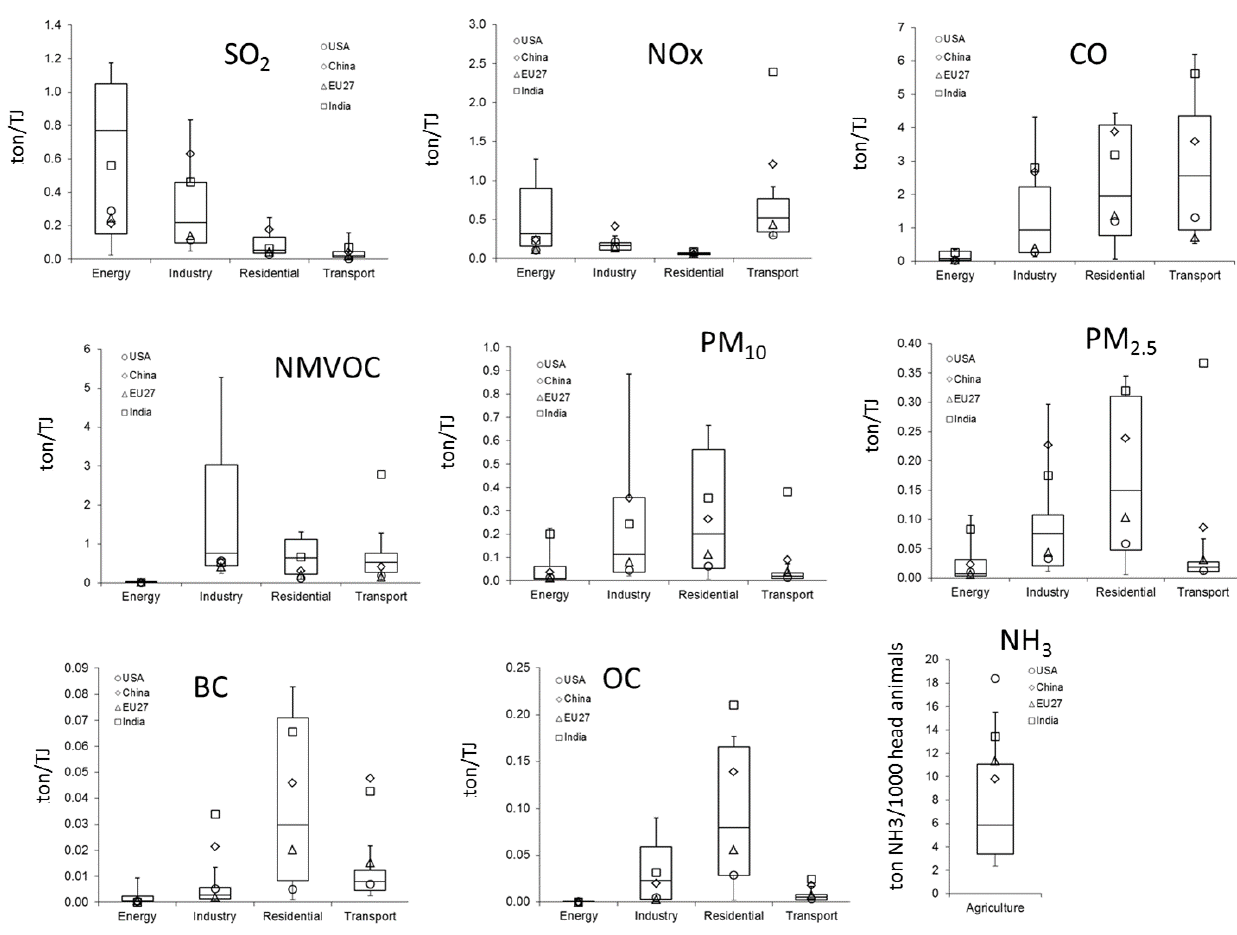
Figure 4. Sector specific implied emissions factors (ton(TJ) − 1 ) for the year 2010. Percentiles are reported in the box plots (10, 25, 50, 75, and 90 ◦ ) together with implied emission factors for specific regions (EU27, USA, China and India). Note – For the percentiles the following countries are left out. For CO – for the industry sector: Togo, Eritrea, Congo, Côte d’Ivoire, Kenya, Benin; for the residential sector: Maldives; for the transport sector: North Korea, Afghanistan, Laos, Tajikistan, Mongolia. For SO 2 – for the industry sector: Namibia, Laos, Jamaica. For NO x – for the residential sector: Maldives; for the TRANSPORT sector: Afghanistan, Laos, North Korea, Tajikistan. For NMVOC – for the energy sector: Bhutan; for the industry sector: Togo, Eritrea, Côte d’Ivoire, Congo, Cameroon, Kenya, Benin, Aruba, Antigua, Bahamas, Ethiopia, Sudan, Senegal, Equatorial Guinea, Central African Rep., Sri Lanka, Angola, Mozambique, Zambia, Jamaica; for the residential sector: American Samoa, Gum, Maldives, Tonga; for the transport sector: Afghanistan, Laos, North Korea. For PM 10 – for the industry sector: Togo, Eritrea, Côte d’Ivoire, Congo, Kenya, Benin, for the transport sector: Afghanistan. For PM 2 . 5 – for the energy sector: Tajikistan, Luxembourg; for the industry sector: Togo and Eritrea; for the transport sector: Afghanistan. For BC – for the energy sector: Nigeria, Malaysia, Belgium, Oman, Finland, Georgia, Vietnam, Canada, Armenia, Tunisia, Jordan, The Netherlands, Trinidad and Tobago, Algeria, Latvia, United Arab Emirates, Brunei, Turkmenistan, Japan, Mozambique, Congo, Qatar, Bahrain, Moldova, Kyrgyzstan, South Korea, Taiwan, Luxembourg, Bhutan, Tajikistan; for the industry: Trinidad and Tobago, Malta; for the transport sector: Afghanistan. For OC – for the energy sector: Tunisia, Jordan, Trinidad and Tobago, Algeria, United Arab Emirates, Brunei, Turkmenistan, Tajikistan, Mozambique, Congo, Qatar, Bahrain, Kyrgyzstan, Taiwan, Myanmar, South Korea, Vietnam; for the industry sector: Bahrain, Eritrea; for the residential sector: Greenland, Gibraltar, Faroe Islands, Saint Pierre et Miquelon; for the transport sector: Afghanistan. For NH 3 – for the agriculture sector: Faroe Islands, Tajikistan, Greenland, Falkland Islands, Kyrgyzstan, South Korea, Brunei, American Samoa, Malaysia, Trinidad and Tobago, Bahamas, Saint Pierre et Miquelon, Sri Lanka, Suriname, Réunion, Thailand, Indonesia, Japan, Barbados, Bhutan, Guyana, Costa